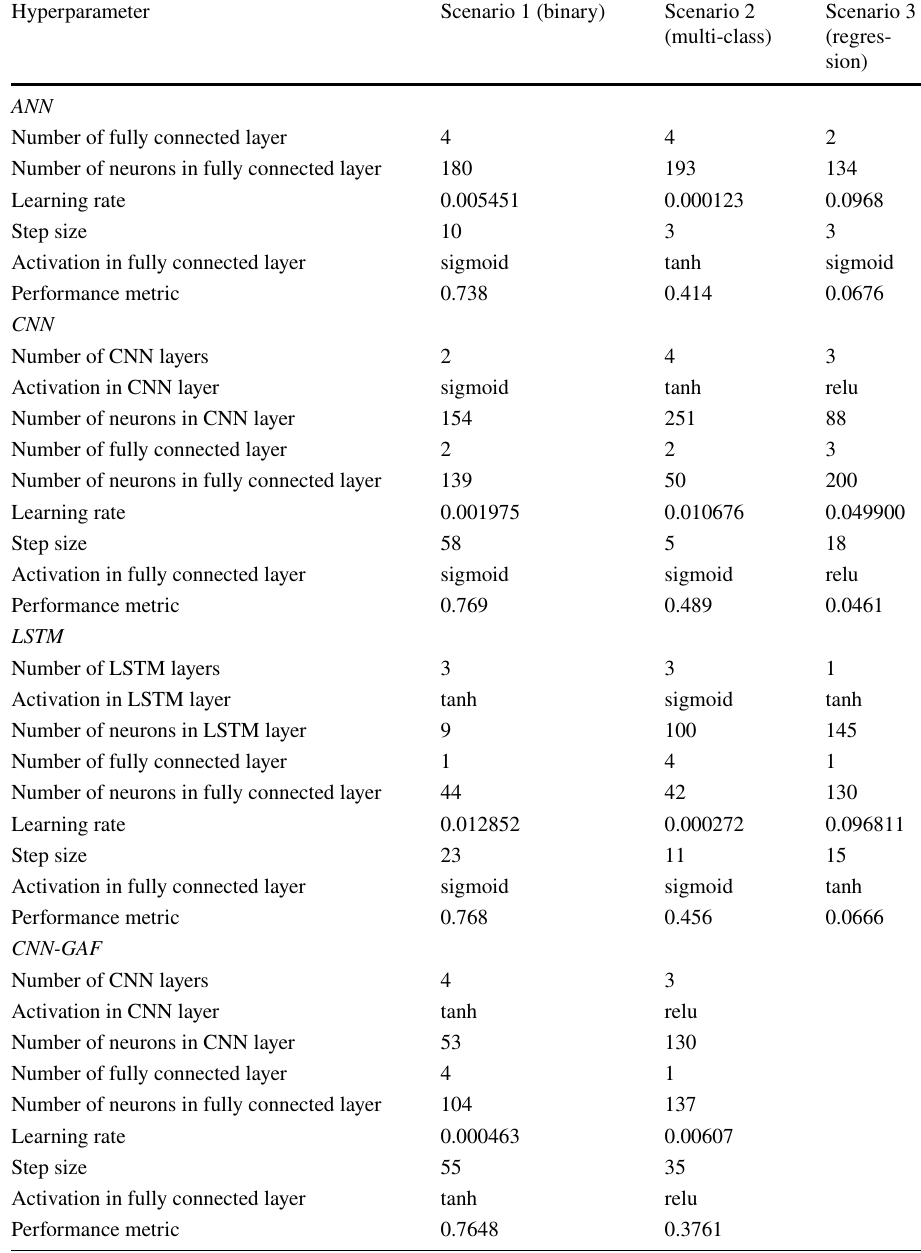
Table 5 The tuned hyperparameters of the neural network algorithms